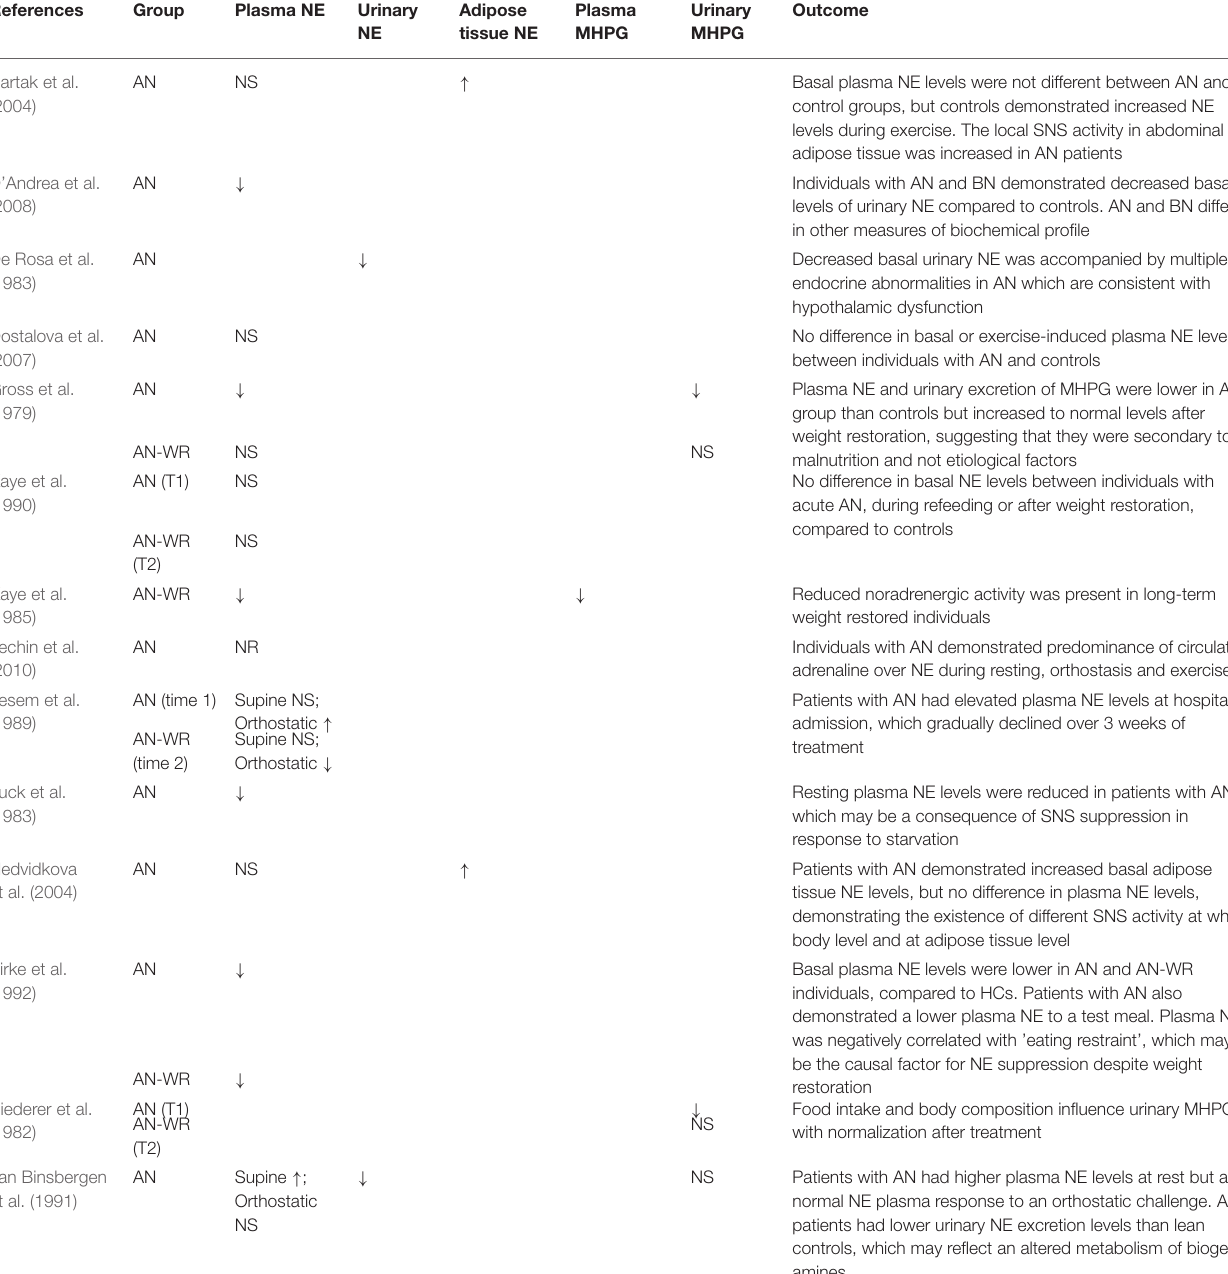
TABLE 5 | Basal noradrenaline and MHPG levels, as compared to